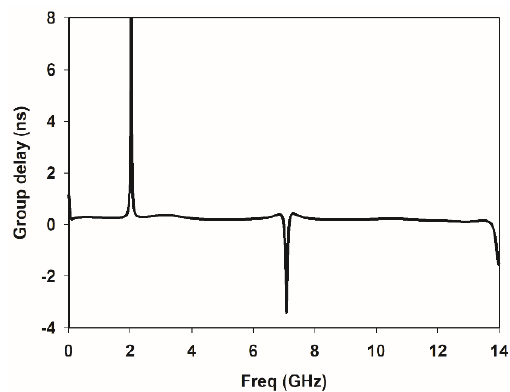
FIGURE 10. simulated group delay .